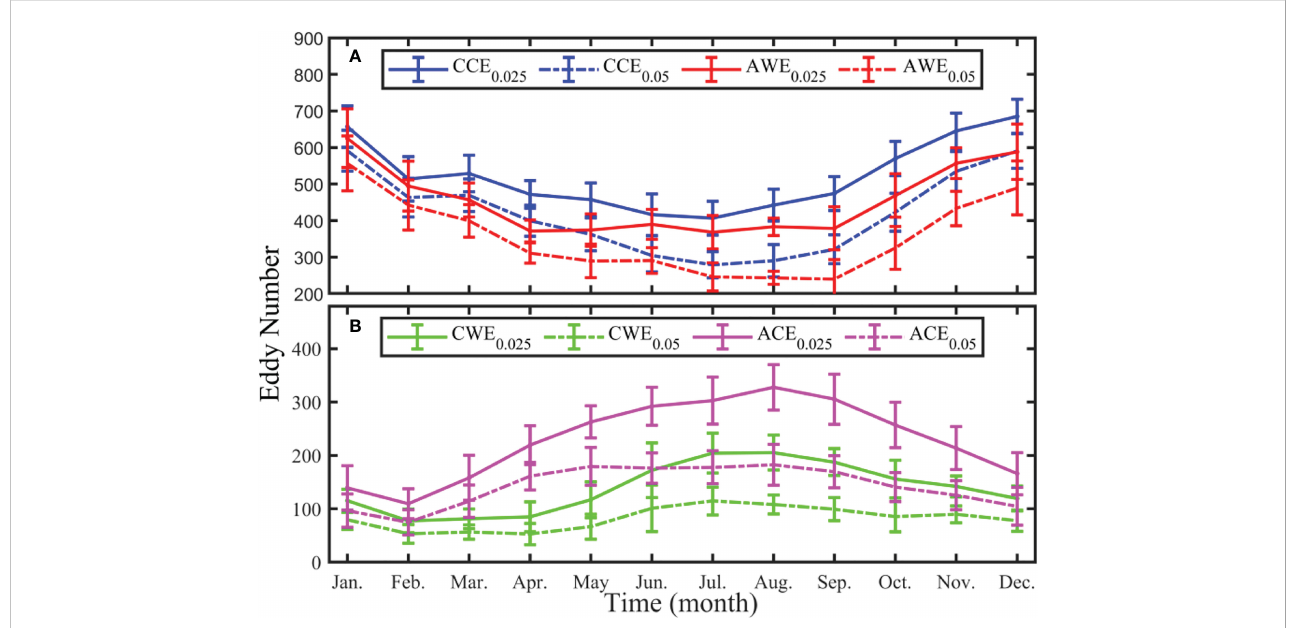
FIGURE 10 Monthly distribution of multi-year (2008 ~ 2017) average eddy number under different temperature threshold conditions (0.025 and 0.05°C) in the STCC area. (A) Cyclonic cold-core and anticyclonic warm-core eddy, and (B) cyclonic warm-core and anticyclonic cold-core eddy.